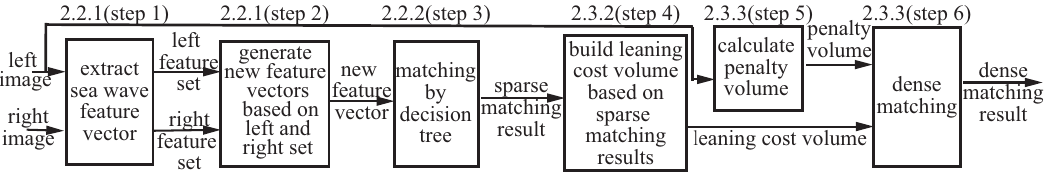
Figure 10. Summary of processing steps in Section